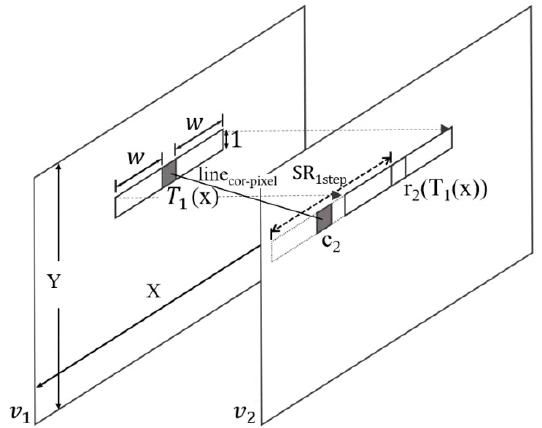
Figure 2. Initial EPI estimation to obtain the predicted slope of line cor ‐ pixel .